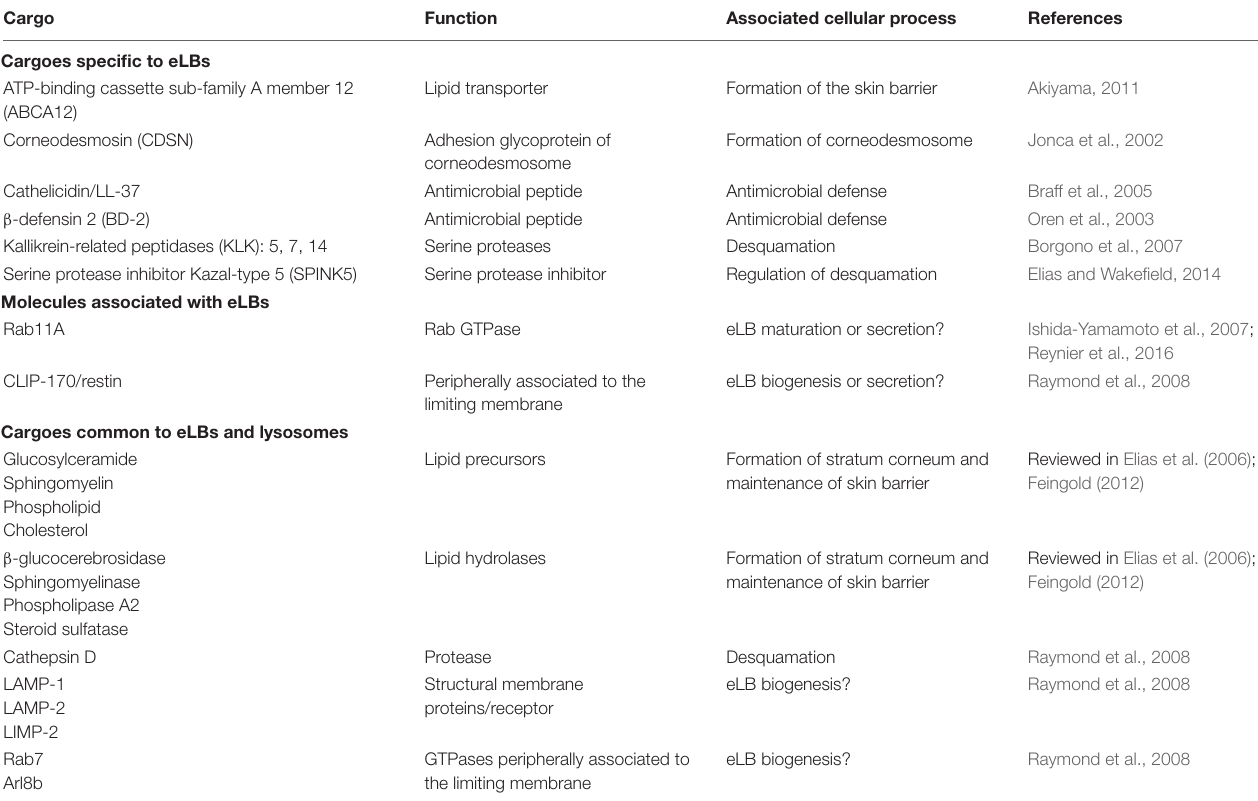
TABLE 1 | List of cargoes specific to eLBs and shared with the